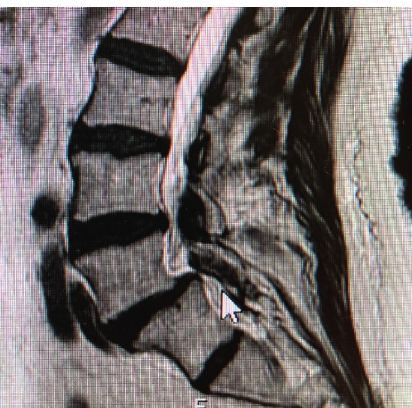
Figure 1: MRI lumbar spine with contrast showing grade 1 spondylolisthesis at L5–S1 with S1-S2 disk space causing severe spinal stenosis. There is a large object extending inferiorly from L5–S1 disk space.